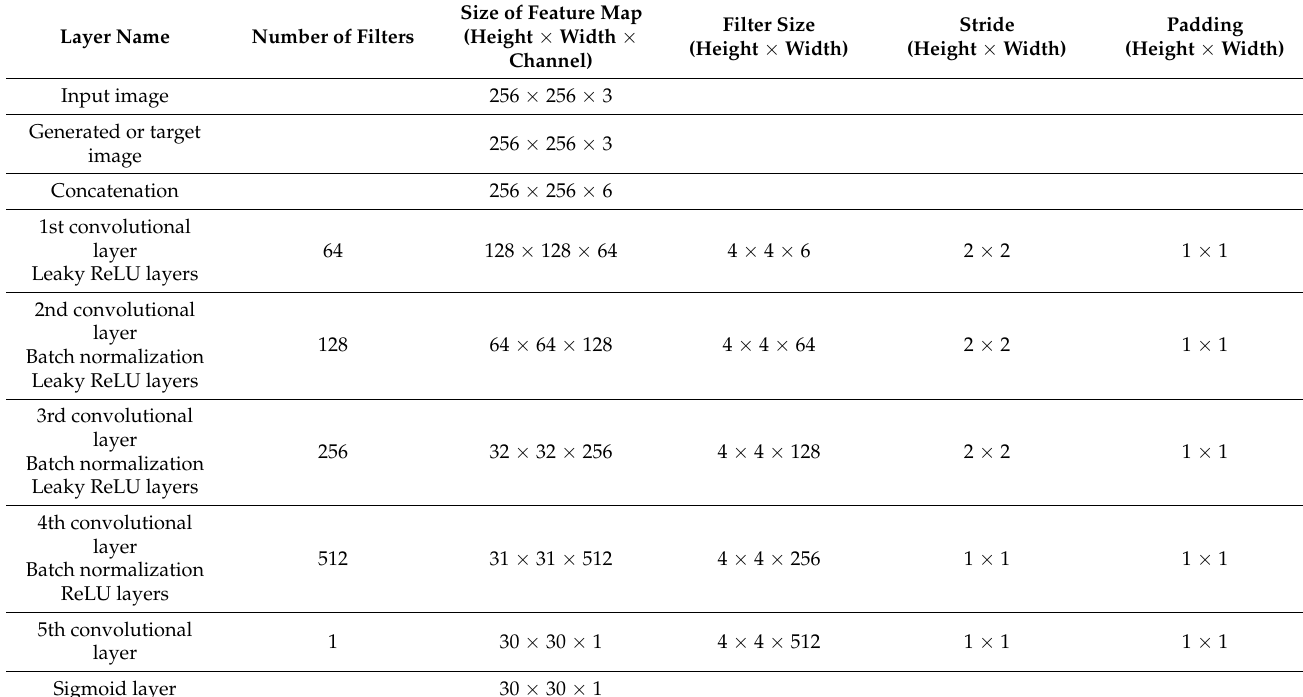
Table 4. Discriminator structure in